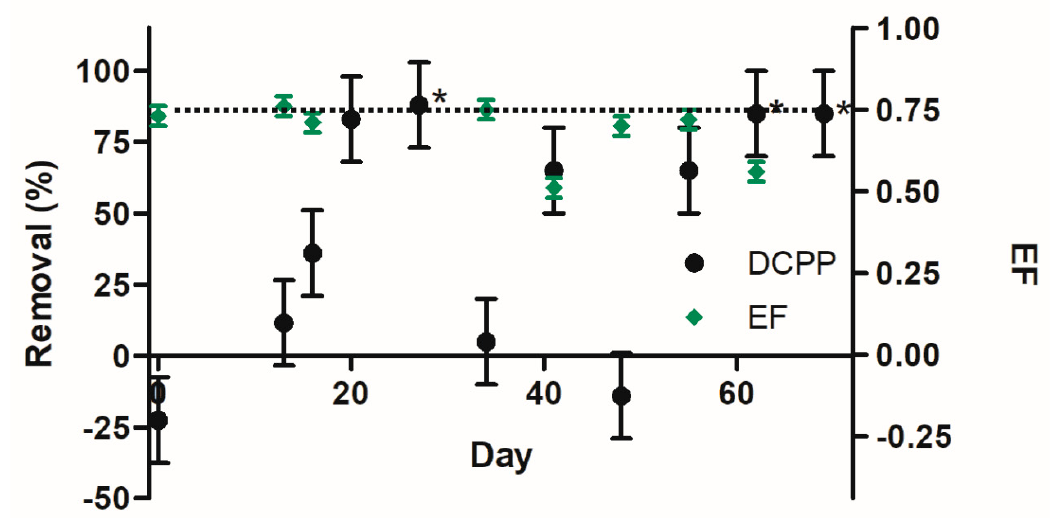
Figure 4. Removal ( • ) and EF ( (cid:4) ) for dichlorprop in the sand biofilter. The dotted line represents Figure 4 . Removal ( ● ) and EF ( ■ ) for dichlorprop in the sand biofilter. The dotted line represents the the average EF (0.75) of the inlet water. The error bars were ± 15%, and ± 0.03 for removal, and EF, average EF (0.75) of the inlet water. The error bars were ±15%, and ±0.03 for removal, and EF, respectively. Asterisks mark the points where C out was replaced with respectively. Asterisks mark the points where C out was replaced with LOD.